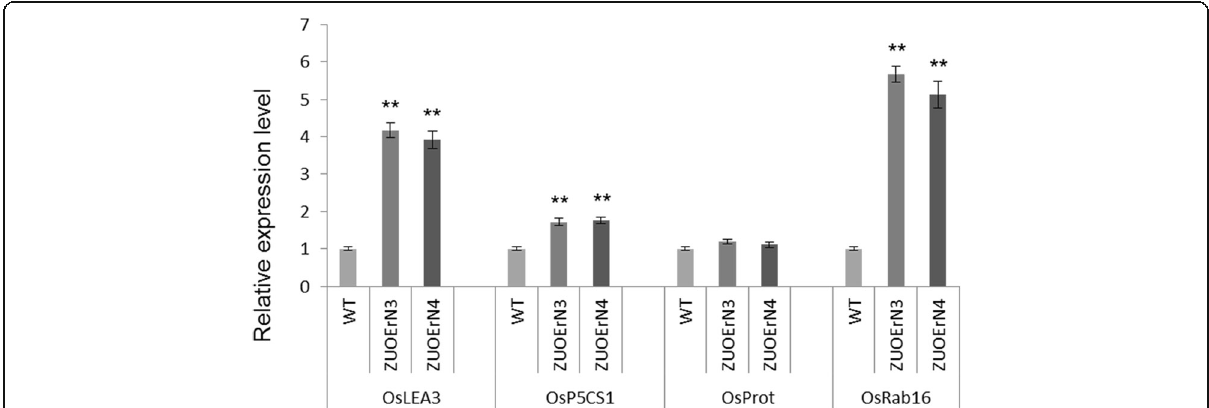
Fig. 6 Expression level of abiotic stress-related genes. The relative expression levels of OsLEA3 , encoding a group 3 late-embryogenesis abundant protein; OsP5CS , involved in biosynthesis of proline, encoding Δ 1-pyrroline-5-carboxylate synthetase; OsProt , encoding a proline transporter; and OsRab16 , encoding a small GTP-binding protein, were assayed using RT-qPCR with seedlings. The data were normalized using the rice UBI gene and are shown relative to WT. Error bars represent SD of three biological replicates. ** P < 0.01 ( t -test)